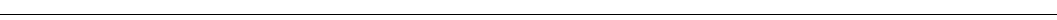
Fig. 5 Myosin-II dynamics in nocodazole-treated cells. a Upregulation of phosphorylated MLC2 (p-MLC2) after nocodazole treatment, assessed by western blotting. Densitometric comparison for the electrophoretic bands is also shown. n = 4 independent experiments, mean ± SEM. b Immunostaining for p- MLC2, F-actin, and E-cadherin in HT29 cells. c Lateral views of HT29 cells immunostained as in b . d Densitometric scans of immunosignals for p-MLC2 and E-cadherin along the yellow line drawn in b . e Time-lapse images of MLC2-EGFP expressed in HT29 cells during nocodazole treatment. Images at the right are a close-up view of the cell indicated by arrow at the left panel. Images are identical to Supplementary Movie 3. f Effects of α E- catenin knockdown on MHC-IIA distribution, as assessed by immunostaining of HT29 cells transfected with control or α E-catenin speci fi c siRNA. Images were obtained with Airyscan. g Effects of nocodazole treatment on the distribution of p-MLC2 and E-cadherin in Colo205, LS180, and SW620 cells. Scale bars, 10 μ m b , c , f left and g ; 2 μ m ( f right). See also Supplementary Fig.